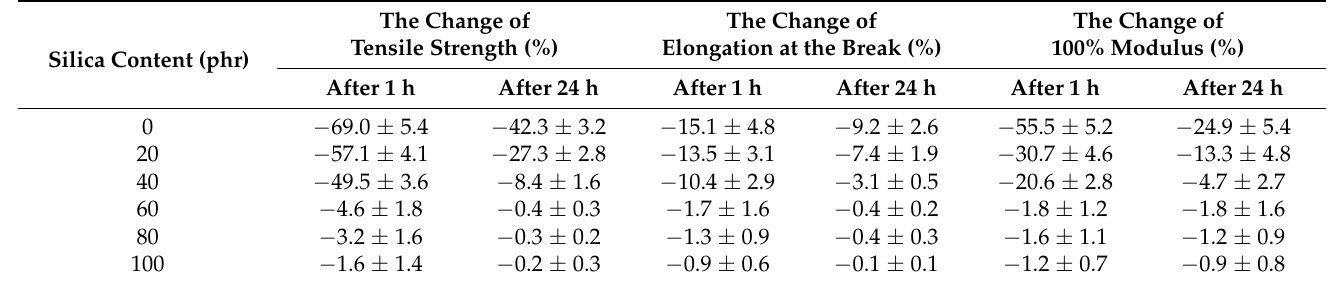
Figure 8. The change in the mechanical properties of EPDM/silica vulcanizates after exposure to 96.3 MPa hydrogen gas for 24 h: ( a ) the change of tensile strength, ( b ) the change of elongation at the break, and ( c ) the change of 100% modulus. Table 5. The change in the mechanical properties after exposure to high-pressure hydrogen gas.